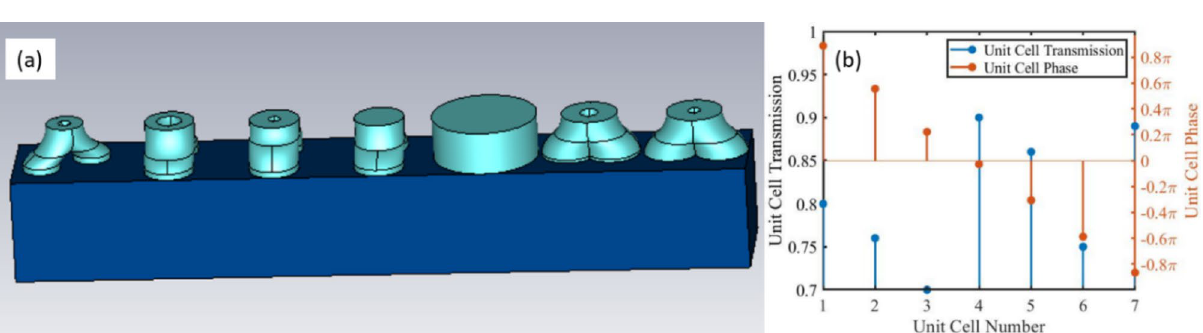
Figure 5. ( a ) The beam steering structure ( b ) Transmission magnitude and phase of each